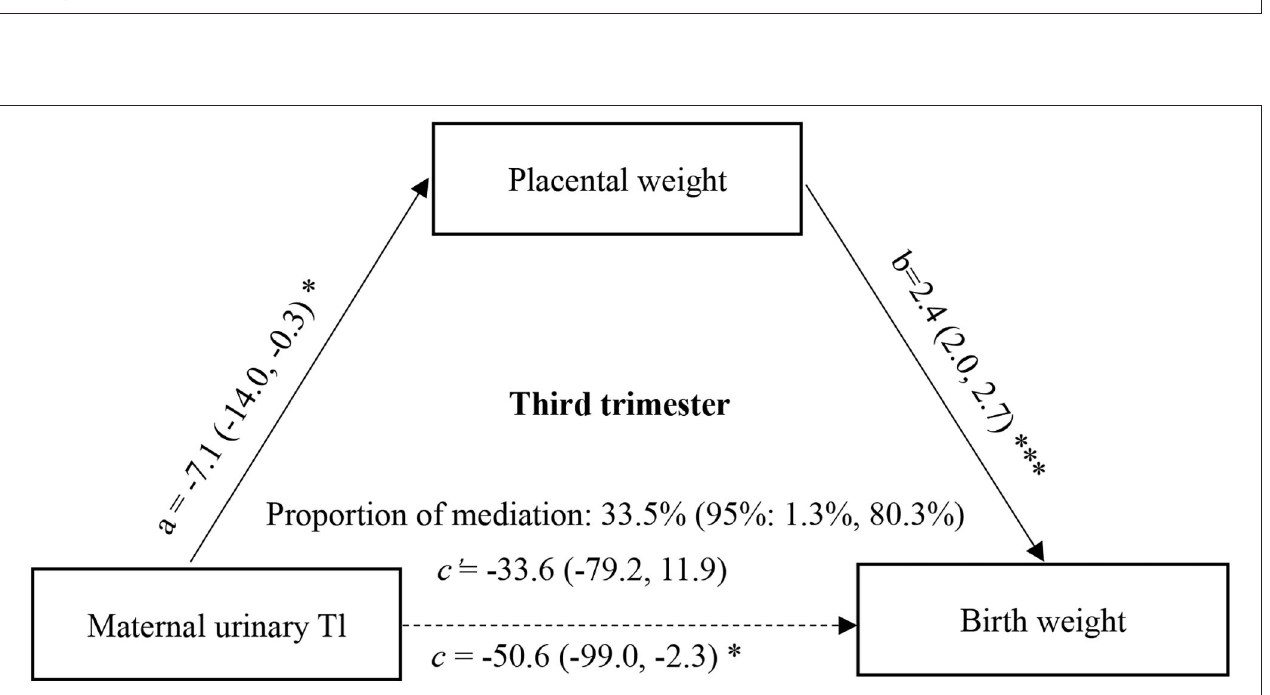
FIGURE 2 | Mediation effect of placental weight on the association of maternal urinary Tl exposure during the third trimester with birth weight. a, c, and c’ were estimated for the highest vs. the lowest tertile of ln-Tl exposure, and b was estimated for each unit increase in placental weight. All effect sizes were adjusted for final analyses: maternal age, maternal education, family income, gestational week, parity, gravidity, infant sex, vegetable consumption, fruit consumption. *** P < 0.001, * P < 0.05.